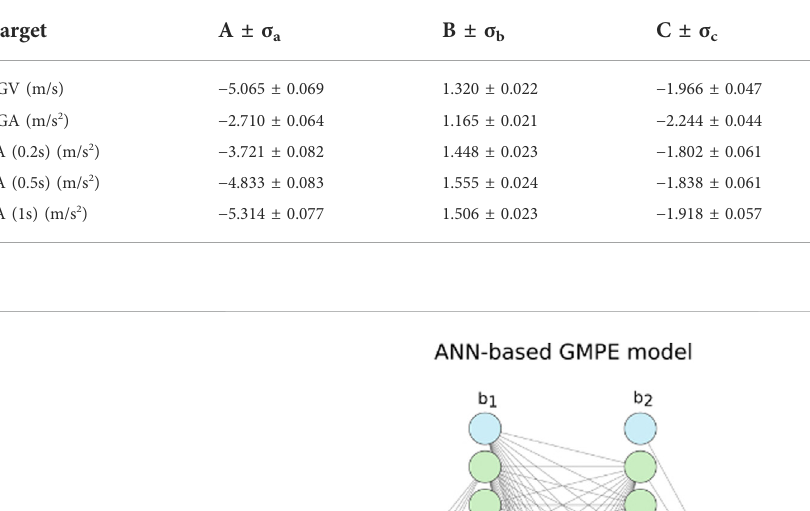
TABLE 1 Coef fi cients and uncertainties of the GMM reported in Eq. 1.